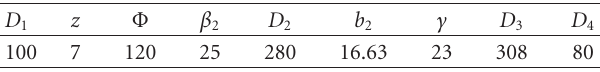
Figure 1: General view of the designed pump. Table 1: Main geometric parameters of the designed pump.